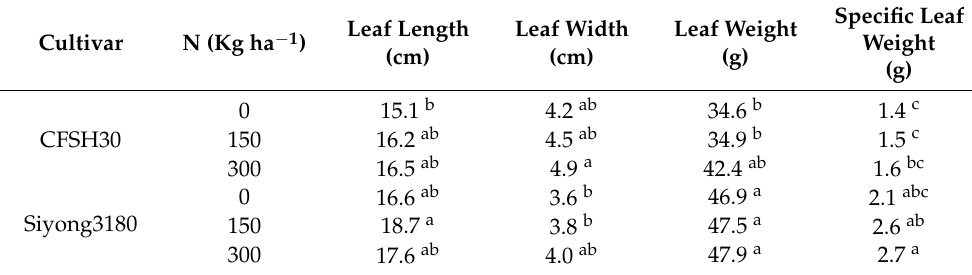
Table 3. Effects of N rates on leaf length, width, and specific leaf weight of two sorghum varieties during 2017.